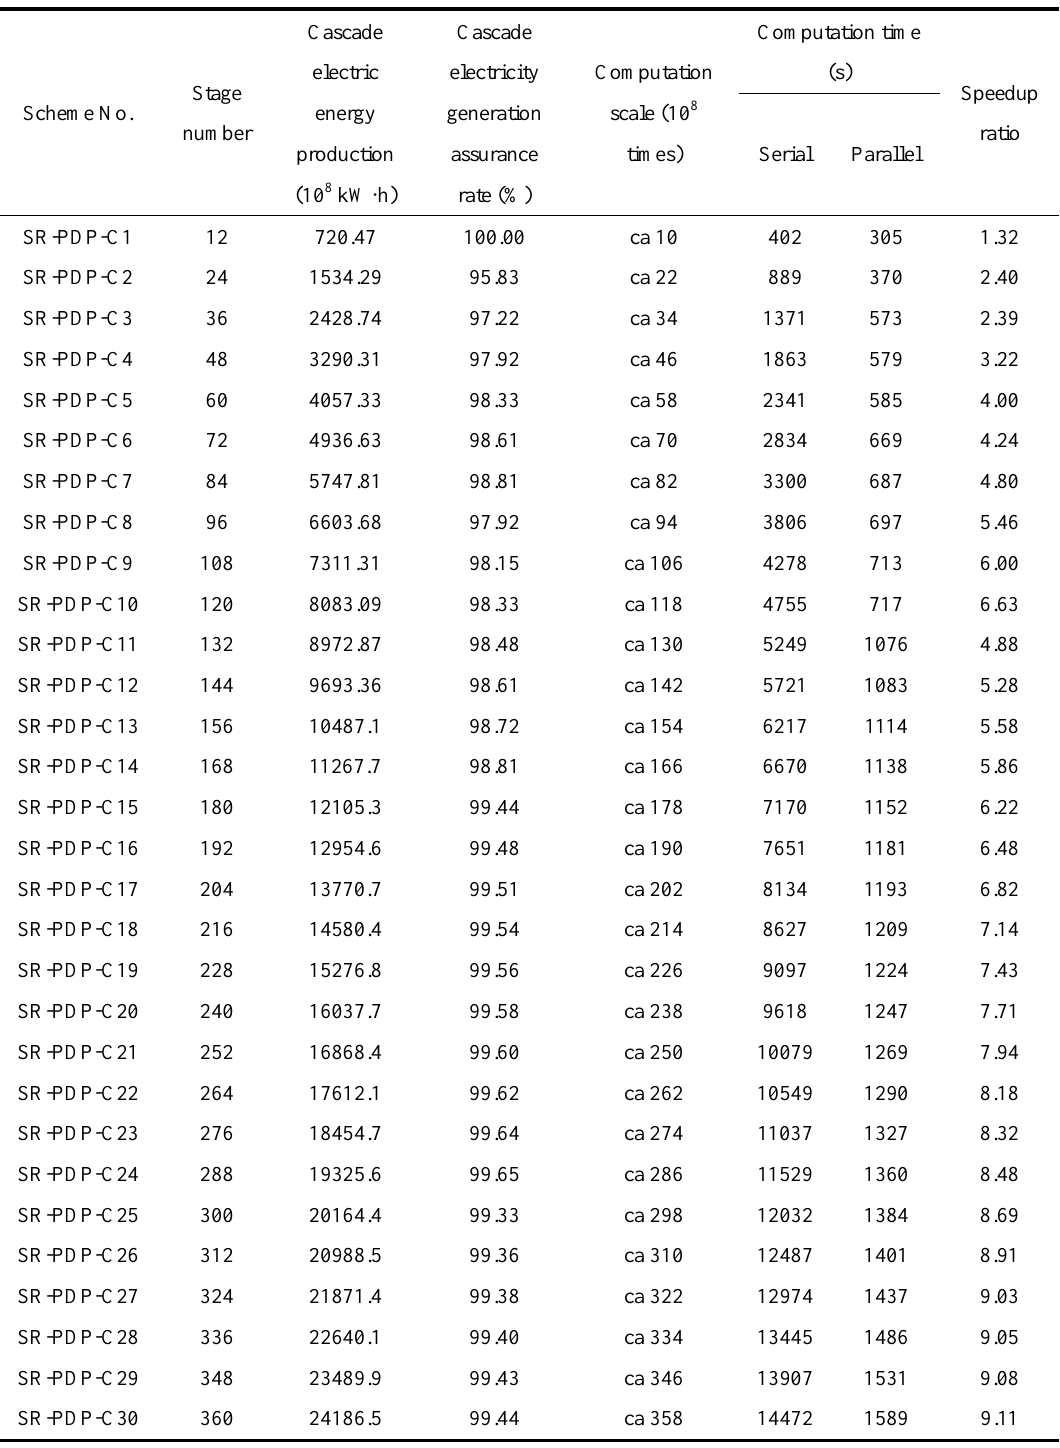
Table 3 Comparison of analog results of schemes with different stage numbers